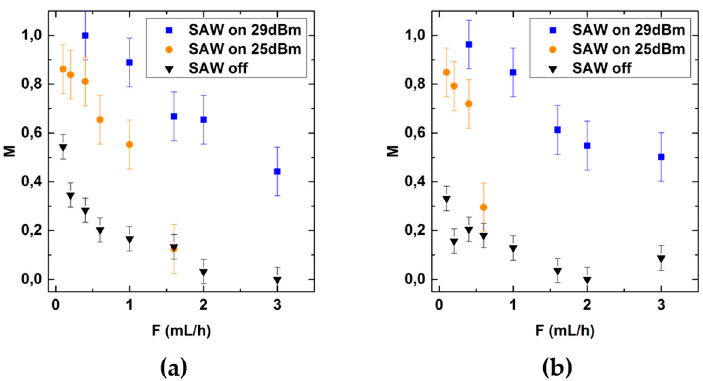
Figure 6. Mixing quality as a function of flow rate F for: ( a ) Ethanol; and ( b ) Isopropanol respectively, with water for P = 25 dBm and P = 29 dBm. The data point and error bars represent the mean and the standard deviation respectively of at least three experiments.